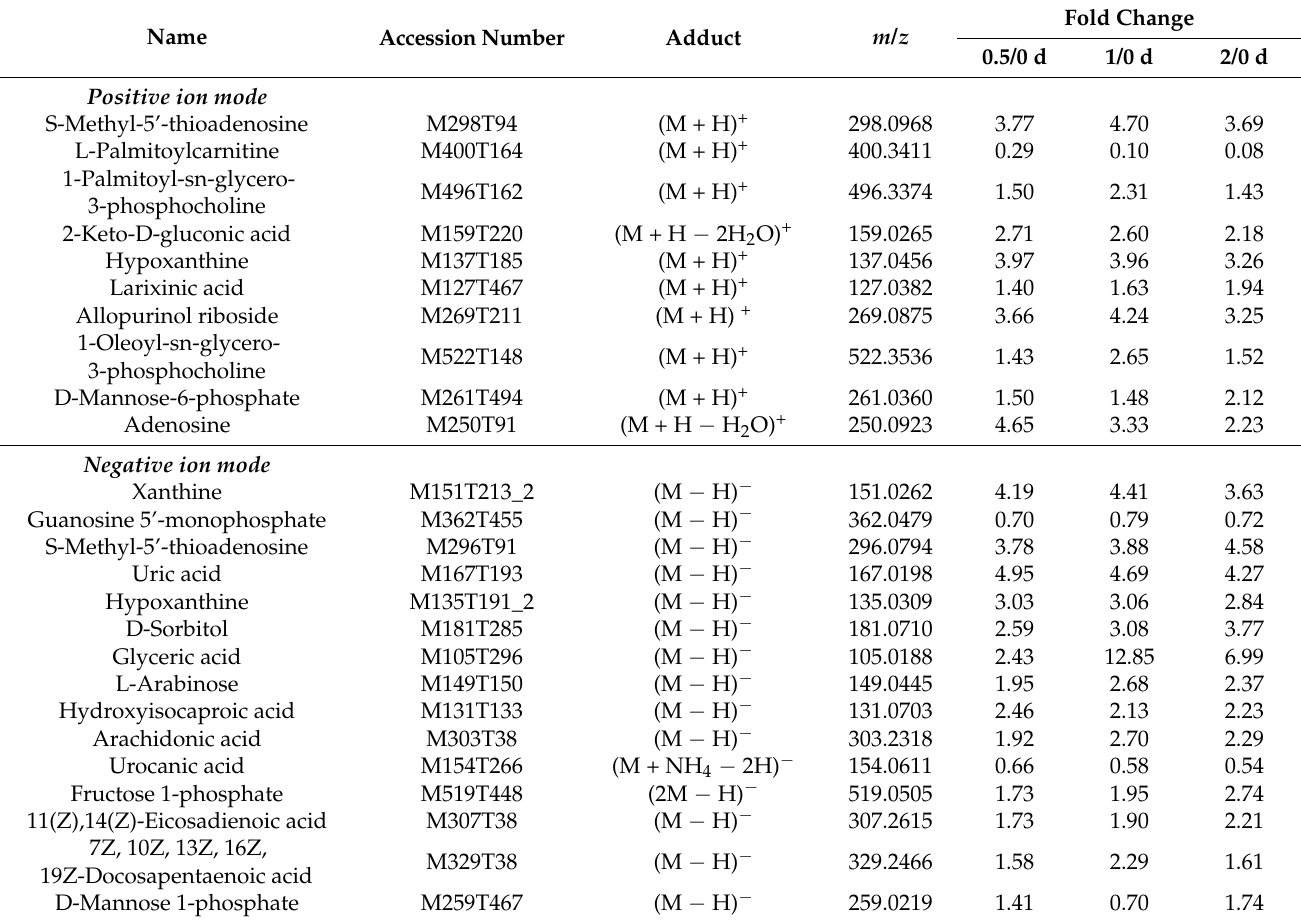
Table 3. Identification of differential metabolites in LL muscle during postmortem